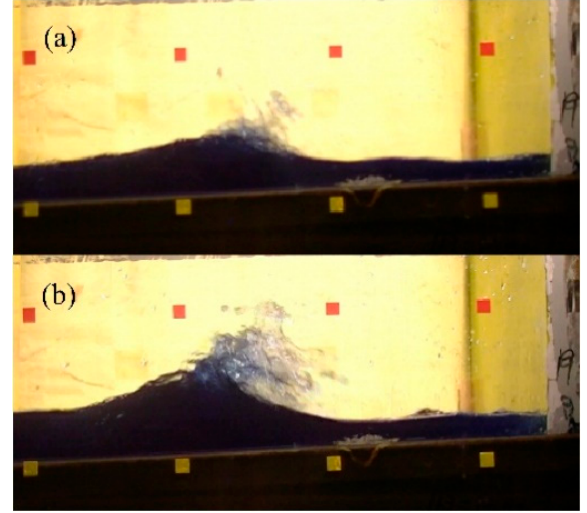
Figure 6. Typical snapshots of the collision of incident broken wave and reflected wave for ( a ) the wave case with H i = 4.7 cm, T i = 1.2 s, h s = 3 cm and ( b ) wave case with H i = 5.5 cm, T i = 1.2 s, h s = 4.5 cm.